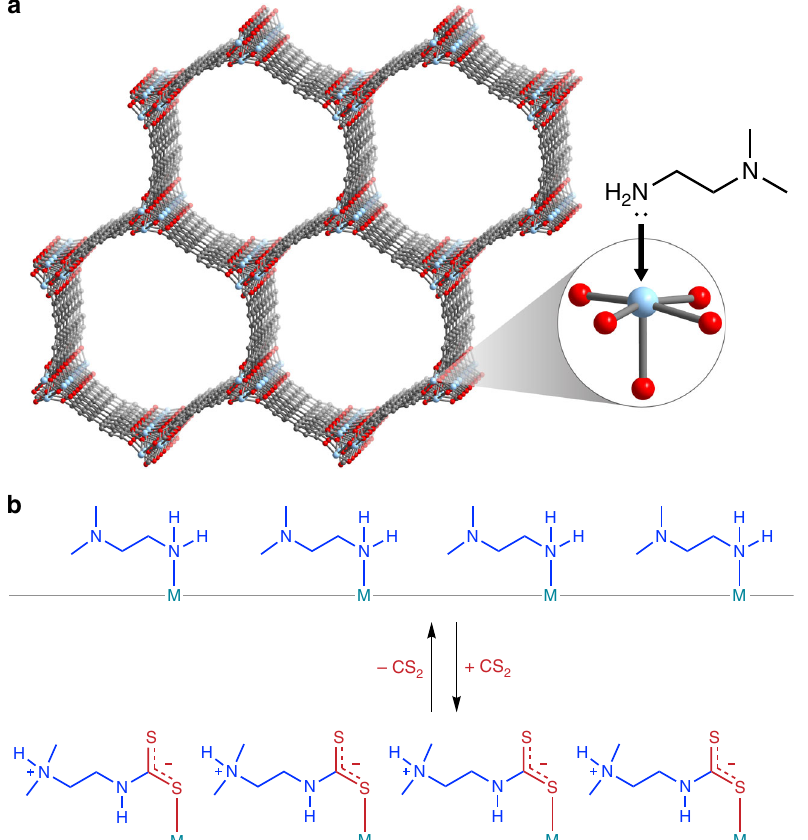
Fig. 2 Adsorbent and proposed cooperative adsorption process. a Representative structure of M 2 (dobpdc) (dobpdc 4- = 4,4 ′ -dioxidobiphenyl-3,3 ′ - dicarboxylate). Light blue, red, and gray spheres represent M, O, and C atoms, respectively; H atoms are omitted for clarity. The inset shows an expanded view of an open metal site appended with the diamine N,N -dimethylethylenediamine (mm-2). b Proposed reversible process for cooperative CS 2 adsorption in mm-2 – M 2 (dobpdc), illustrating insertion of CS 2 into the M – N bonds, proton transfer, and formation of electrostatically paired